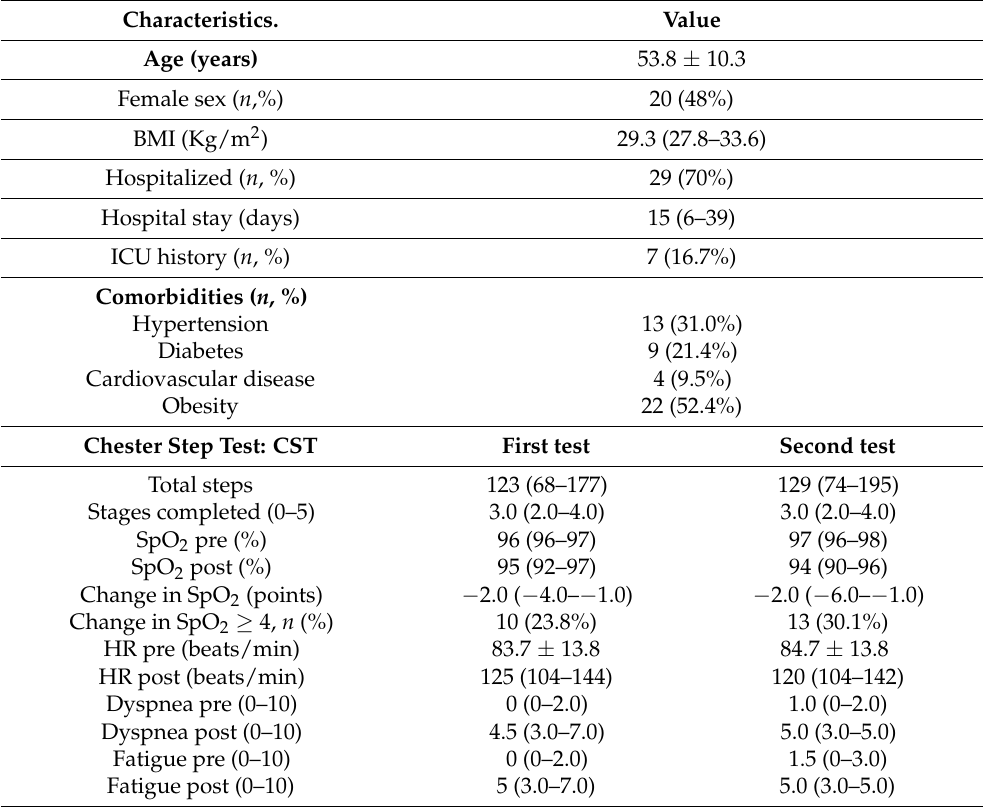
Table 1. Population characteristics and Chester step test in post COVID-19 patients ( n = 42).